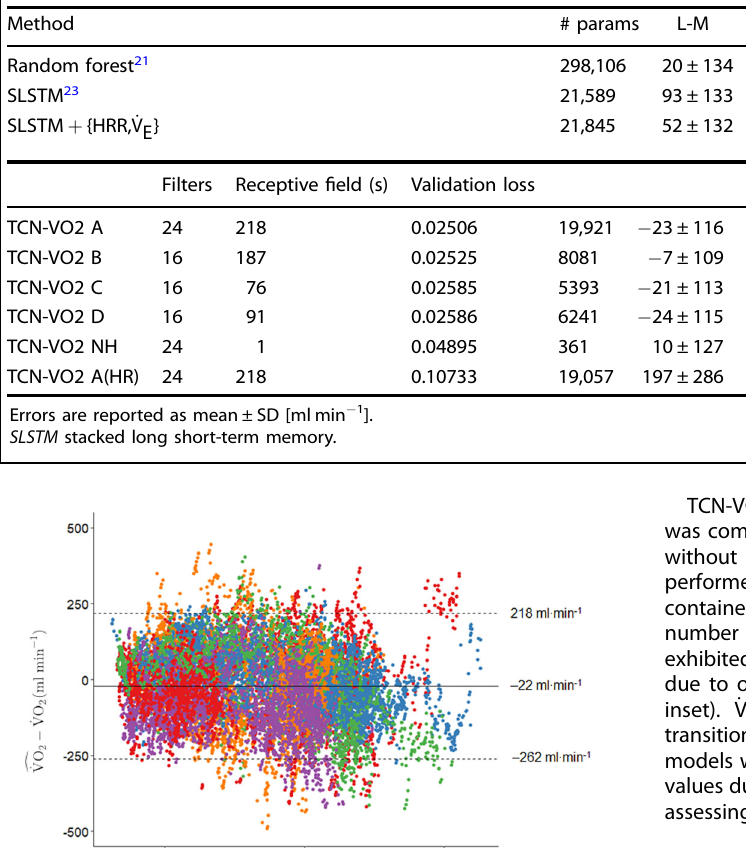
Table 2. Error rates and characteristics of TCN and comparison models.